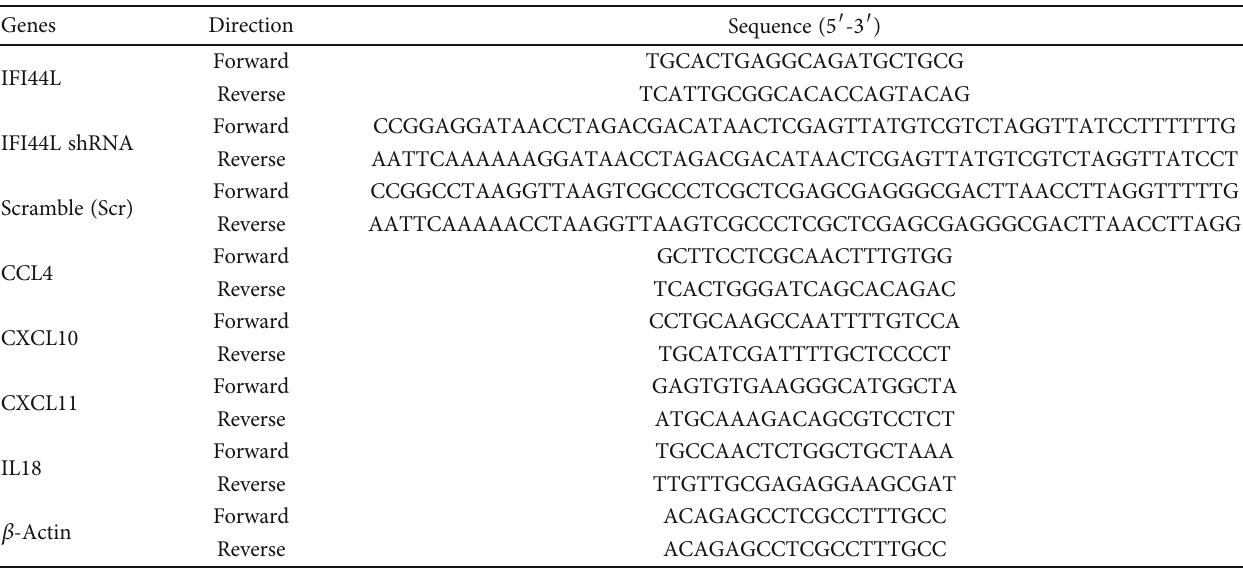
Table 1: Primers for